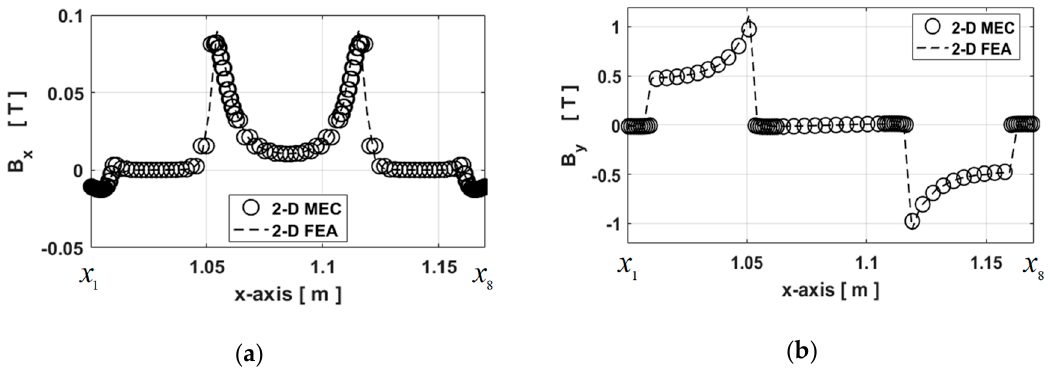
Figure 8. Waveform of B for Path m2 with I max = 7.78 A at t = 0s and h mp = 6mm: ( a ) x- and ( b ) y-component.